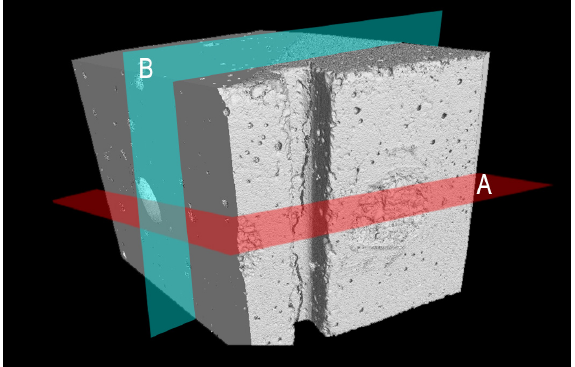
Figure 17. 3D visualization of the portion of the cracked prism that contains the maccherone tube. The two cross line sections were